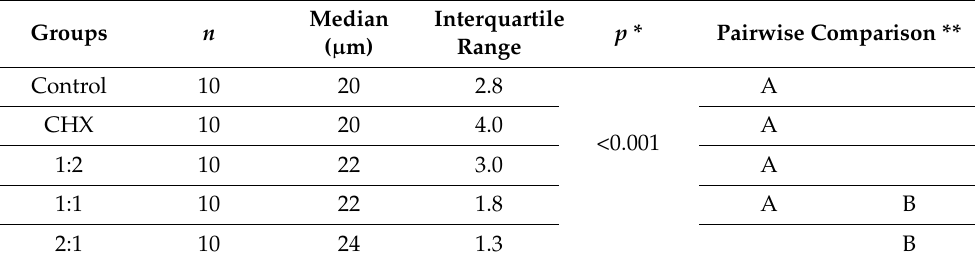
Table 3. Results of the Kruskal Wallis H test for film thickness.